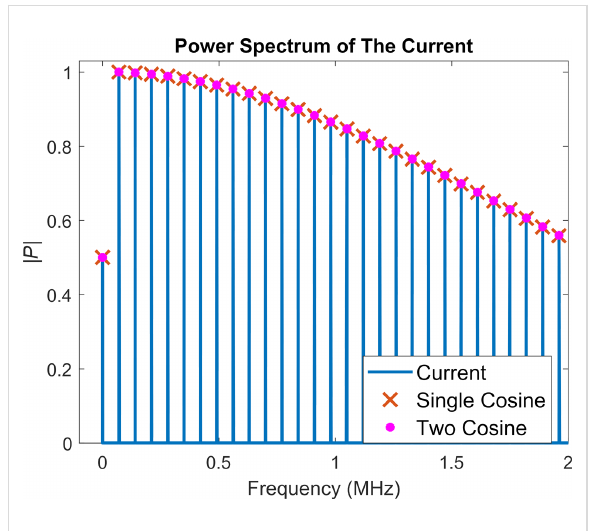
Figure 7: Power spectrum of the current from analytical calculations and numerical cantilever simulations for a noncontact case with attrac- tive tip–sample forces. The blue lines correspond to the calculated power spectrum from the numerical simulation and the orange crosses correspond to the prediction from Equation 13, for the case where only one cosine term is included in Equation 12. The agreement between the two results is very good, as expected, since the higher harmonics of the tip trajectory decrease very rapidly. Pink dots are used to repre- sent the two-cosine analytical prediction. Due to the rapid decrease of the higher harmonic amplitudes of the tip trajectory, the single- and two-cosine results fall almost on top of each other and are visually indistinguishable. The average difference between the single- and two- cosine calculations for the first 50 harmonics is 0.18%. Both calcula- tions are